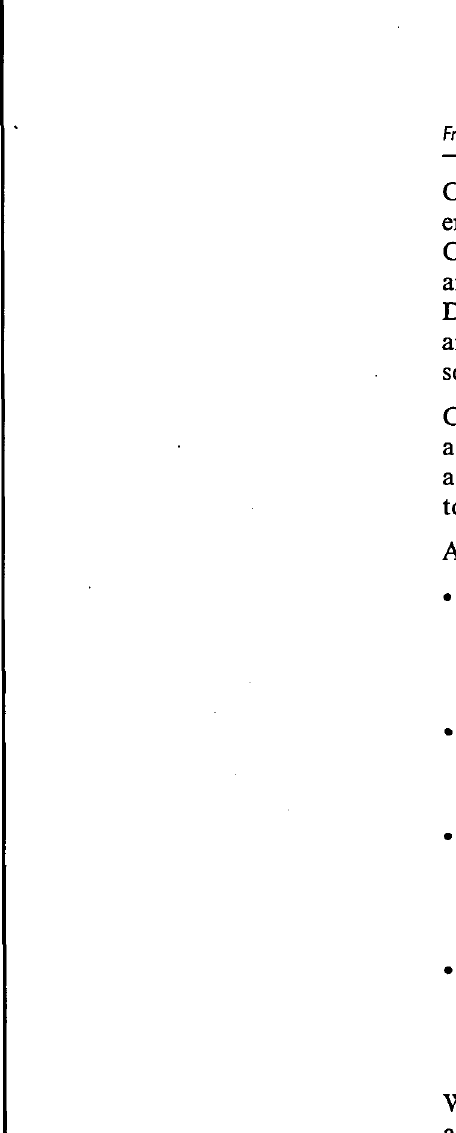
Table 2: Educational objectives served by electronic